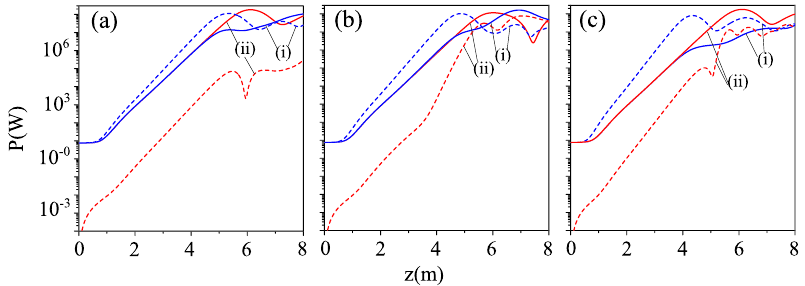
FIG. 6. P ð W Þ as a function of z ð m Þ for (a) m=n ¼ 1 . 5 , (b) m=n ¼ 2 , and (c) m=n ¼ 3 . (i) Blue curves: x and y polarizations both starting from seed. (ii) Red curves: y polarization starting from zero. Solid lines: x polarization; dashed lines: y